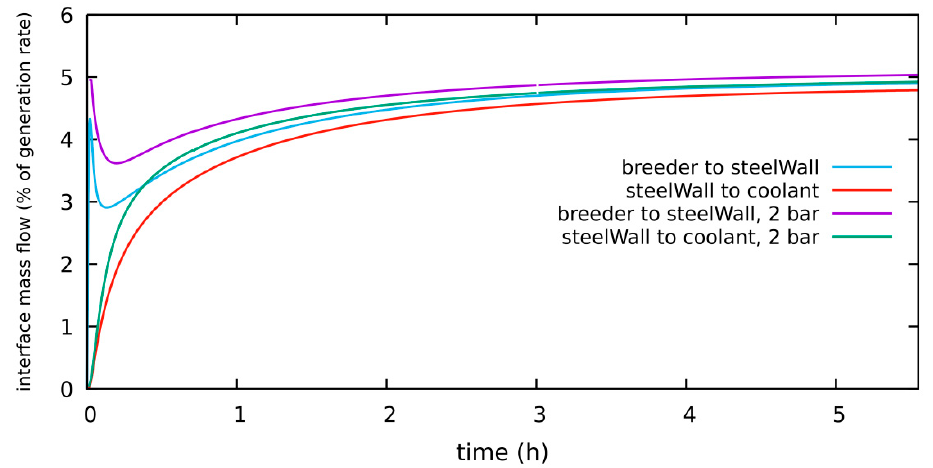
Figure 15. Transient tritium flow through patch interfaces breeder to and from, steel, and steel to and from coolant for 2-bar vs. 80-bar purge gas pressure at equal volumetric flow.